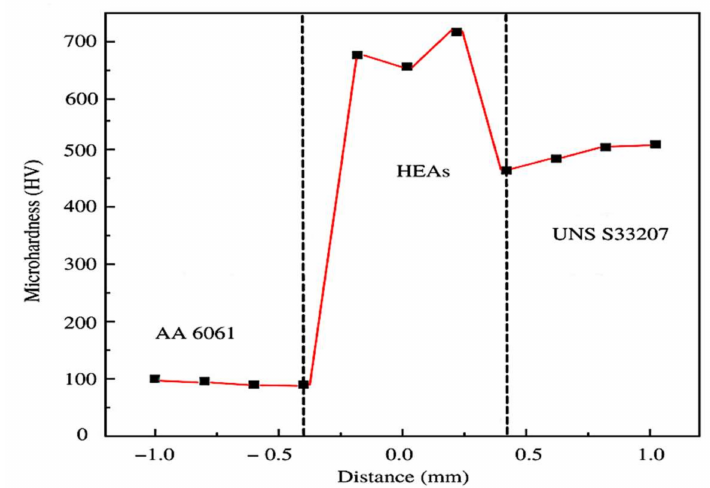
Figure 13. Microhardness profile from the welded joint